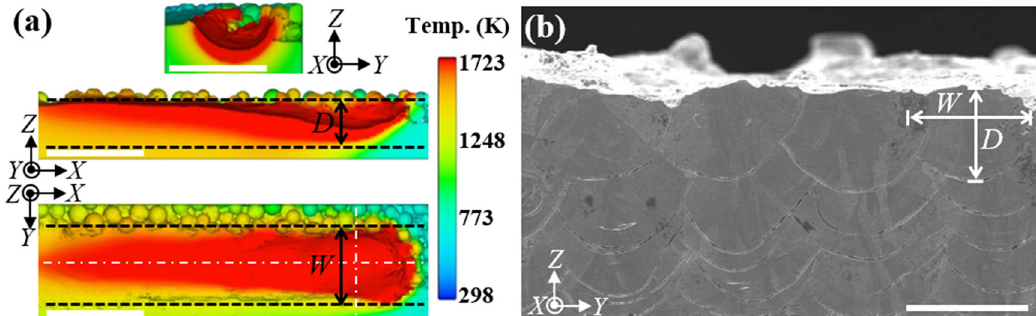
Fig. 3 Molten pool morphology. a Cross sections of the simulated molten pool during the scanning of the 2 nd layer 3 rd track; b molten pool trace in the cross section of the fabricated sample. The white dash-dot lines in a indicate the slice positions of YZ and XZ planes. Scale bars, 200 µm in a and 100 µm in b .